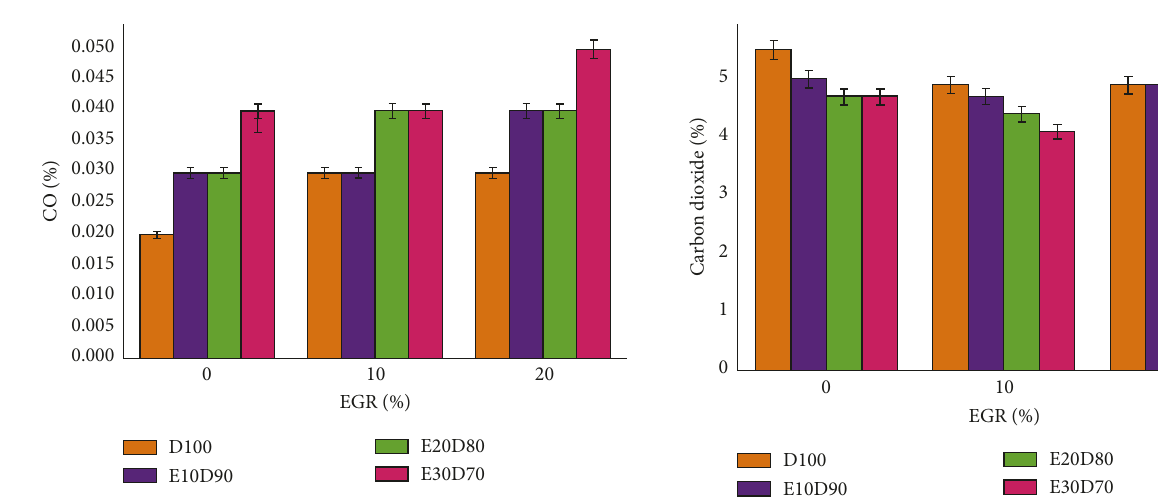
2 with EGR (0%, 10%, and 20%) at 60%